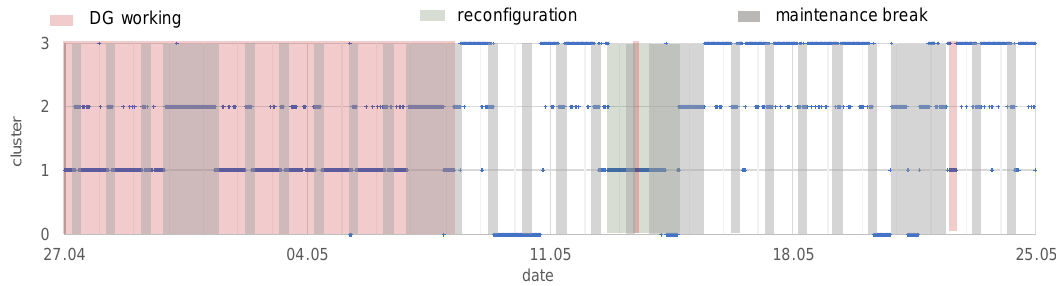
Figure 6. Cluster analysis results for the final number of clusters equal to 3.